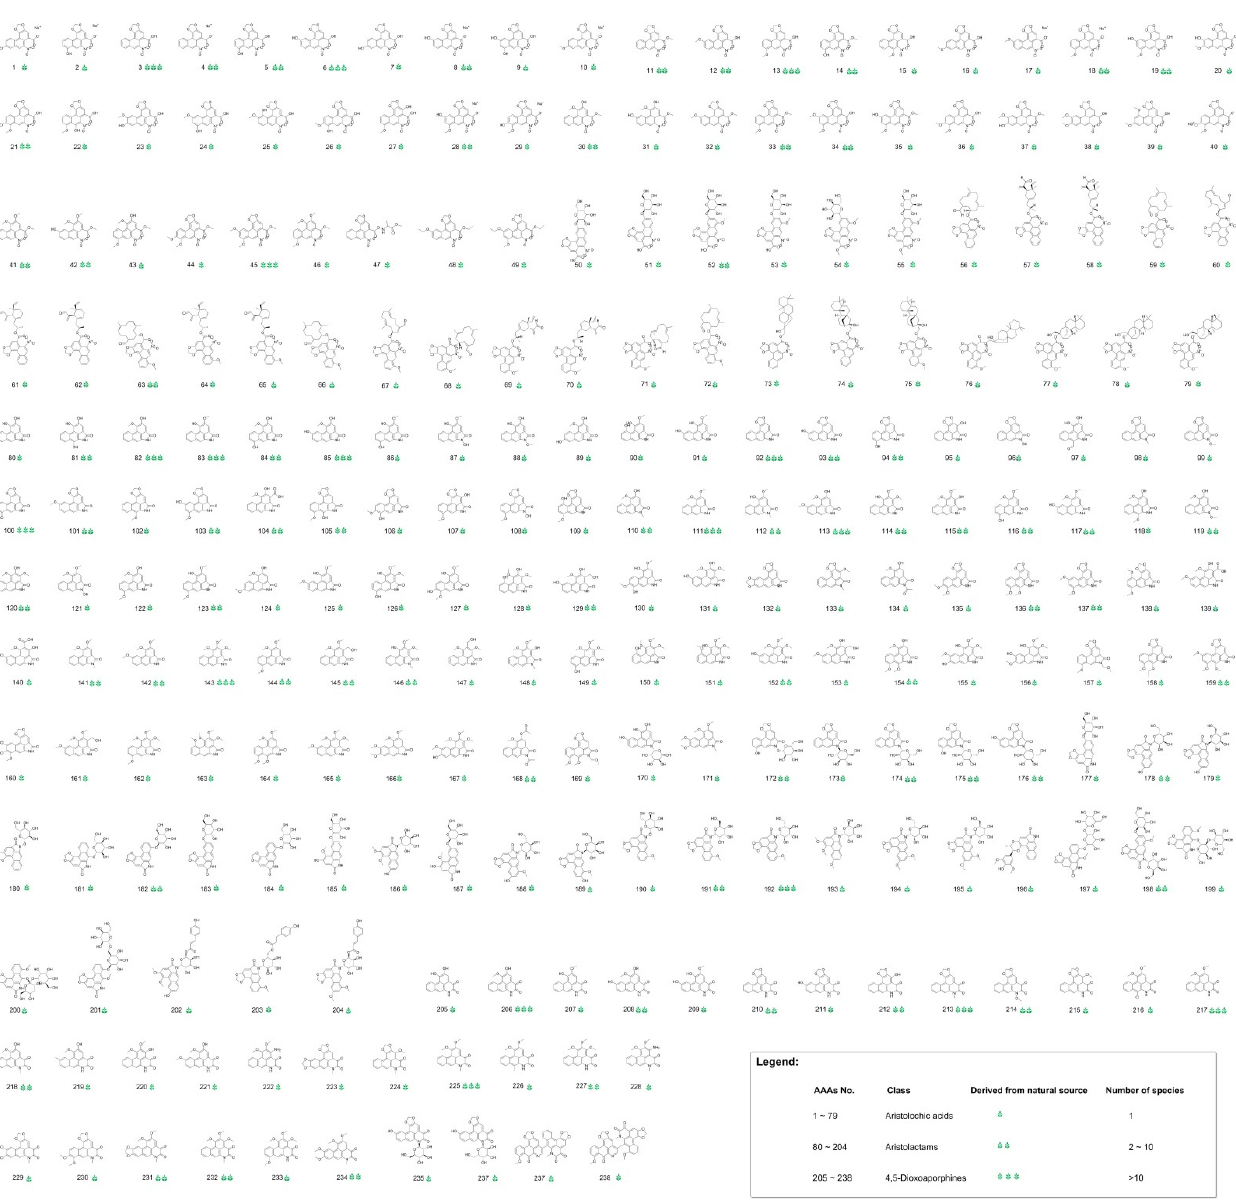
Figure 3. The result of naturally occurring aristolochic acid analogues obtained by virtual screening. High-resolution image file of this figure can be found in Supplementary Materials as Figure S1.